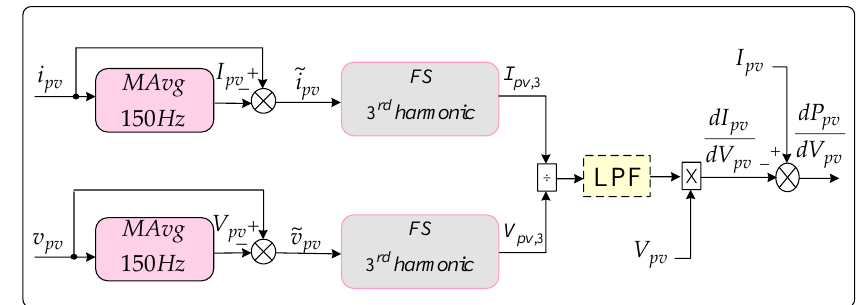
Figure 8. Block diagram of proposed RCC, estimating dP pv / dV pv by the 3 rd harmonic component.